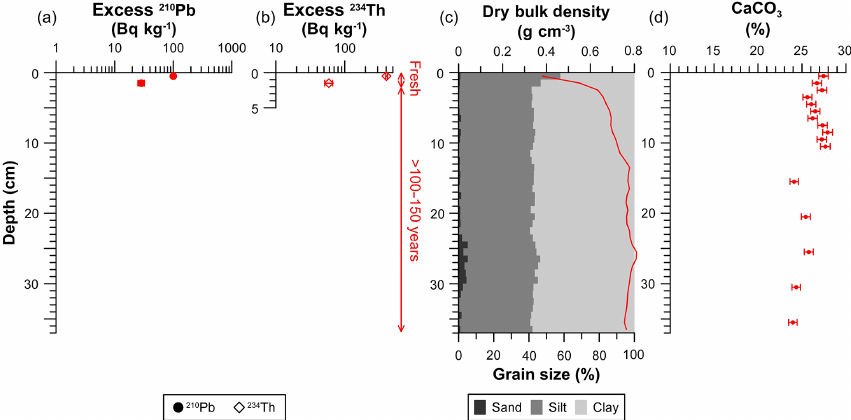
Figure 3. Sedimentological and geochemical characteristics of the trawled sediment core. (a) Concentration profiles of excess 210 Pb. (b) Con- centration profile of excess 234 Th in the upper 5cm. (c) Dry bulk density and grain size profile. (d) CaCO 3 concentration profile. The ana- lytical error is given in horizontal error bars. Vertical scales indicate the process that has occurred in the depth range given. SML: Surface Mixed Layer; SR: Sedimentation